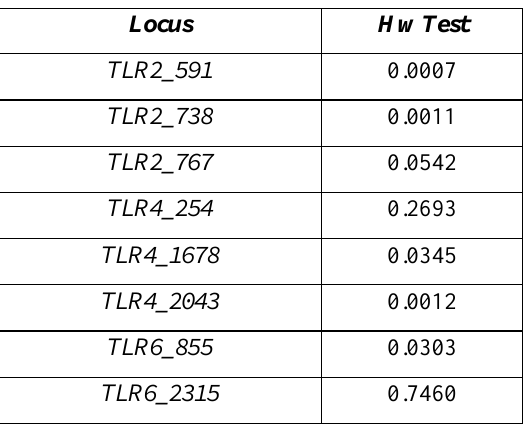
Table 5 . Hardy-Weinberg equilibrium Test.